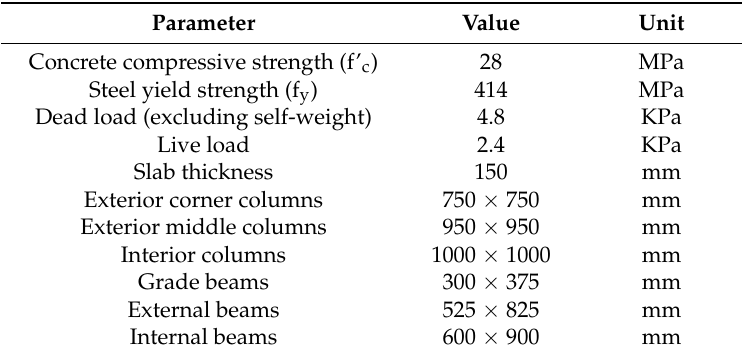
Figure 1. Plan view of a representative multi-storied building. Table 1. Structural parameters.